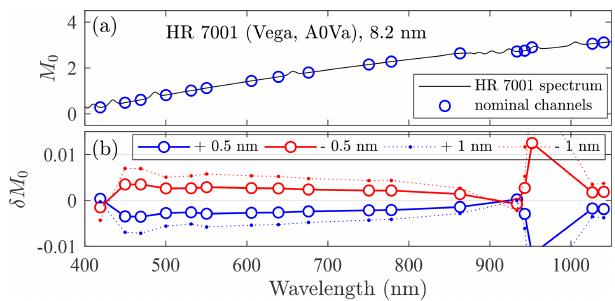
Figure 9. Bandwidth mismatch error for an A-class star (Vega, HR 7001), as a consequence of a spectrum